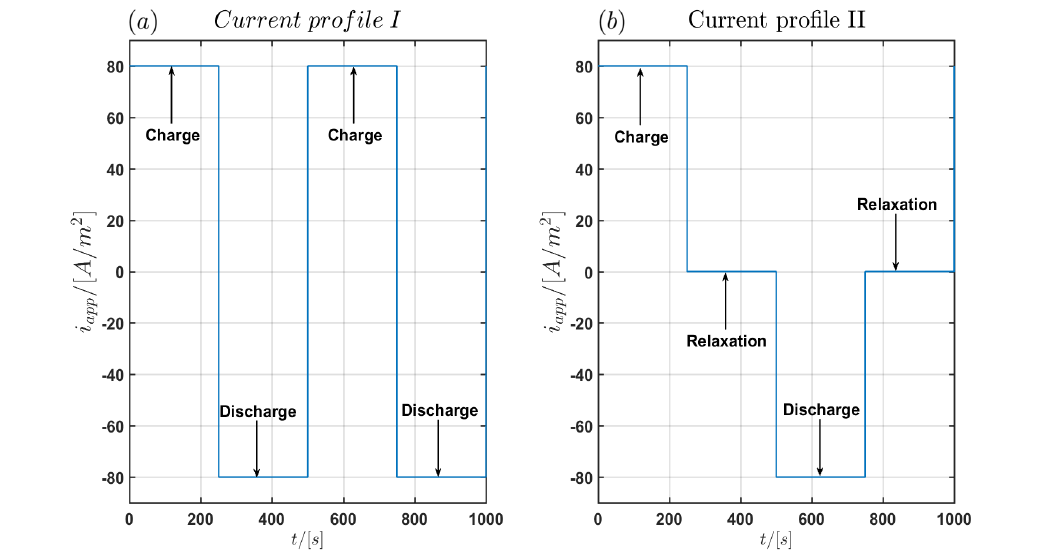
Figure 2. ( a ) First 1000s of the current load profile I without relaxation times and ( b ) of the current load profile II with relaxation times of 250 s between charging and discharging